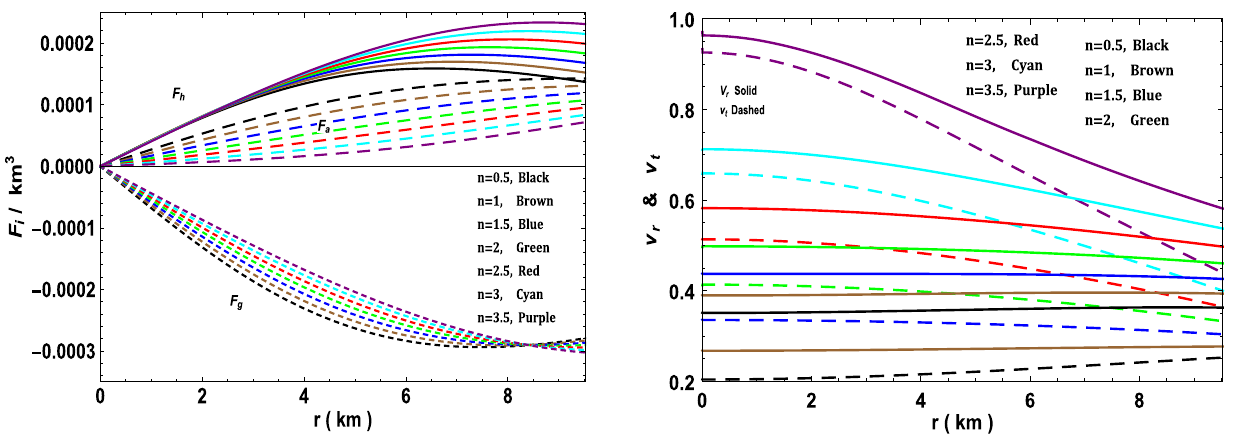
Fig. 12 Variation of forces in TOV-equation with radial coordinate r for 4U 1608-52 ( M = 1 . 74 M (cid:9) , R = 9 . 528 km) by taking a = 0 . 001 km − 2 and β = 0 . 01